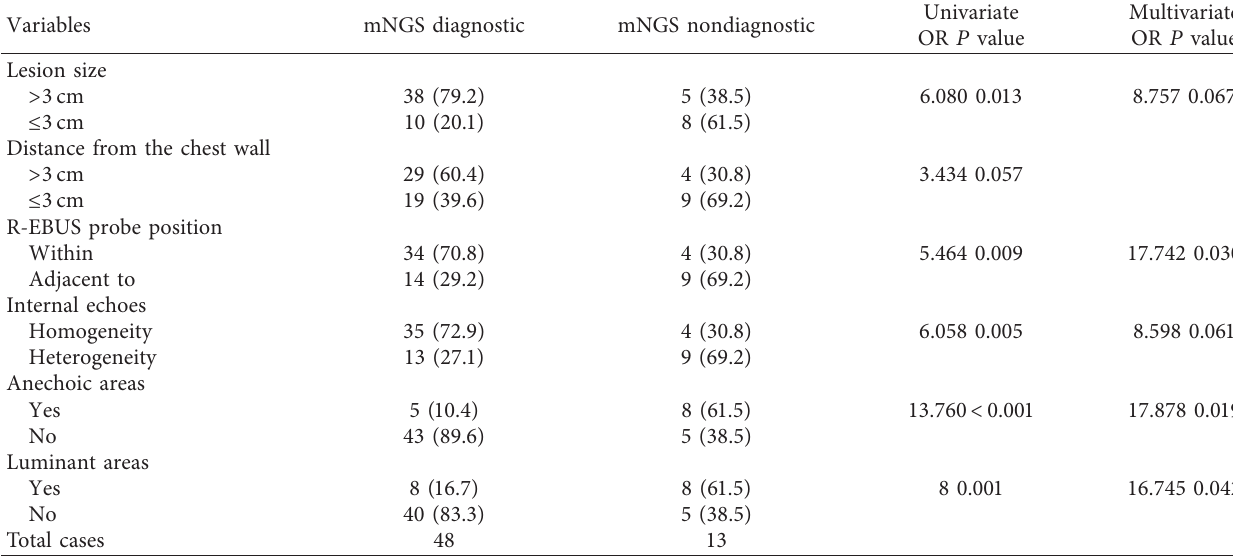
Table 2: The relationship between clinical and image characteristics of PPLs and the diagnostic yield of R-EBUS-guided TBLB detected infectious pathogens by mNGS ∗